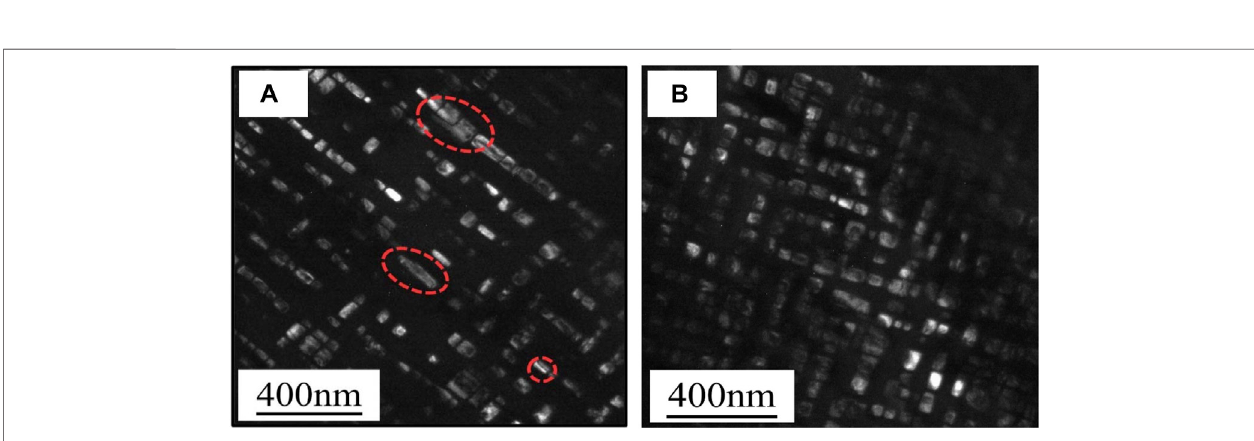
Frontiers in Materials |